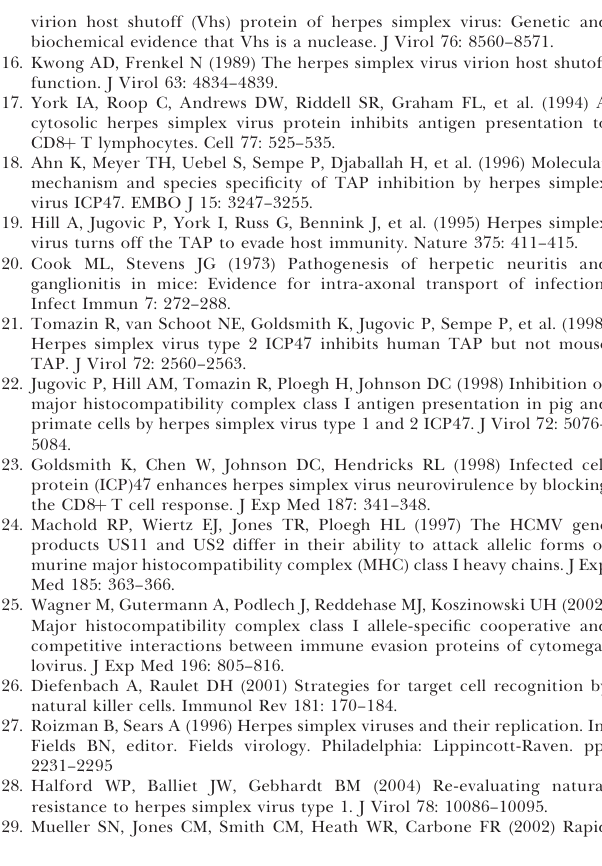
Figure S1. Depletion of CD4 T Cells Does Not Equalize Spinal Cord Titers of 27 gfp Compared to 27US11 or 27m152, Whereas Depletion of CD8 T Cells Does BALB/c mice were either (A) untreated; or (B) and (C) treated 3 and 2 days before the time of infection with 200 l g a -CD4 MAb (GK1.5) or a -CD8 MAb (53–6.7), respectively. Mice were infected with 2.5 3 10 5 pfu of 27 gfp, 27US11, or 27m152 on day 0, and footpads and spinal are similar to those shown in Figures 6A and 7C,